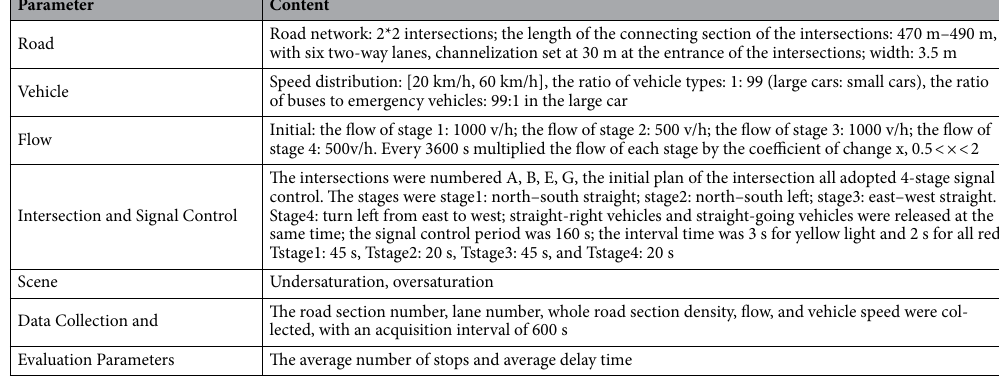
Table 1. Basic parameters of simulation.